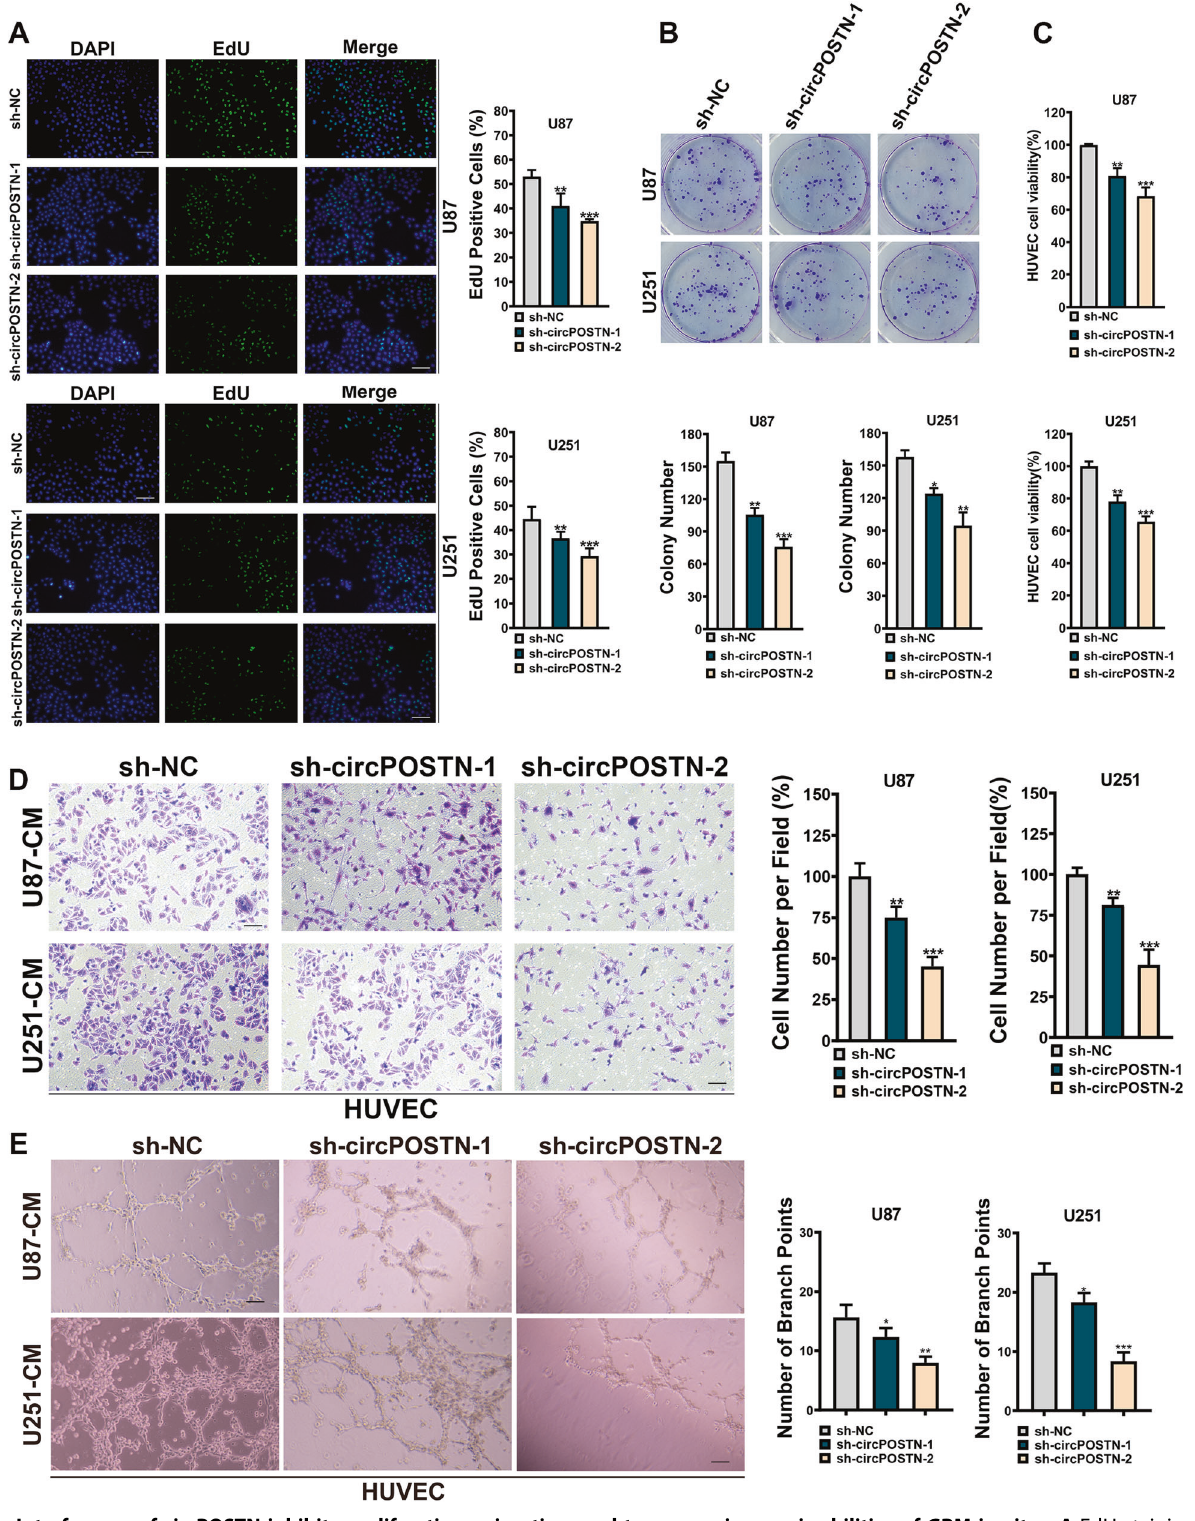
Fig. 3 Interference of circPOSTN inhibits proliferation, migration, and tumor angiogenesis abilities of GBM in vitro. A EdU staining was used to measure the proliferation ability of GBM cells (U87 and U251) after circPOSTN knockdown with two individual shRNAs (sh-circPOSTN-1 and sh-circPOSTN-2). B The in fl uence of circPOSTN silencing on clone formation ability of GBM cells was assessed using clone formation assay. C – E The HUVECs were cultured in the conditional medium from U87 and U251 cells transfected with sh-NC, sh-circPOSTN-1, or sh-circPOSTN- 2. C The effect of circPOSTN knockdown on HUVECs proliferation was detected by MTT assay. D Transwell migration assays were performed to determine the migration ability of HUVECs. E The effect of circPOSTN interference on tubule formation of HUVECs was measured by tubule formation assay. The quanti fi cation of tubule formation was de fi ned based on the branch points and tube numbers. Data are presented as the mean ± SD. * P < 0.05, ** P < 0.01, *** P < 0.001. Cell Death Discovery (2022)